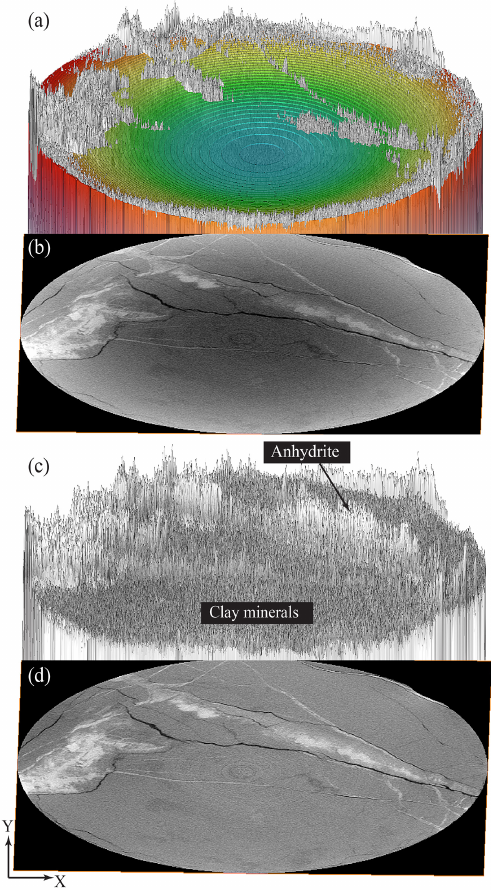
Figure 4. BH correction after noise filtering, where (a) depicts the 2-D polynomial surface, fitted to the original image grey-scale val- ues (b) . The red–blue colour range in (a) represents the elevation of the fitted surface from higher to lower grey-scale values. (c) de- picts the plot representing the residual grey-scale range of values as a result of the surface fitting, and (d) the reconstruction of the BH-corrected